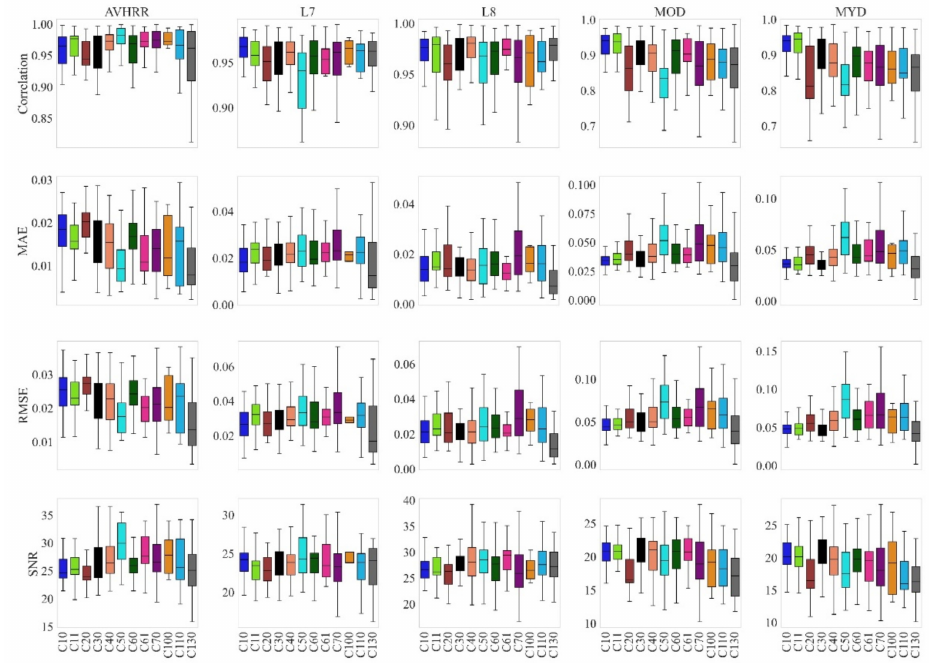
Figure 9. Boxplots of the localized sensor comparison in different land covers. X-axis denotes the land cover classes (LC) in QTP (coded by values as shown in Table 3). The first-row represents the CC, the second-row shows the MAE, the third-row highlights RMSE, and the fourth-row points to the SNR values for AVHRR, EMT+, OLI, MOD, and MYD sensors,